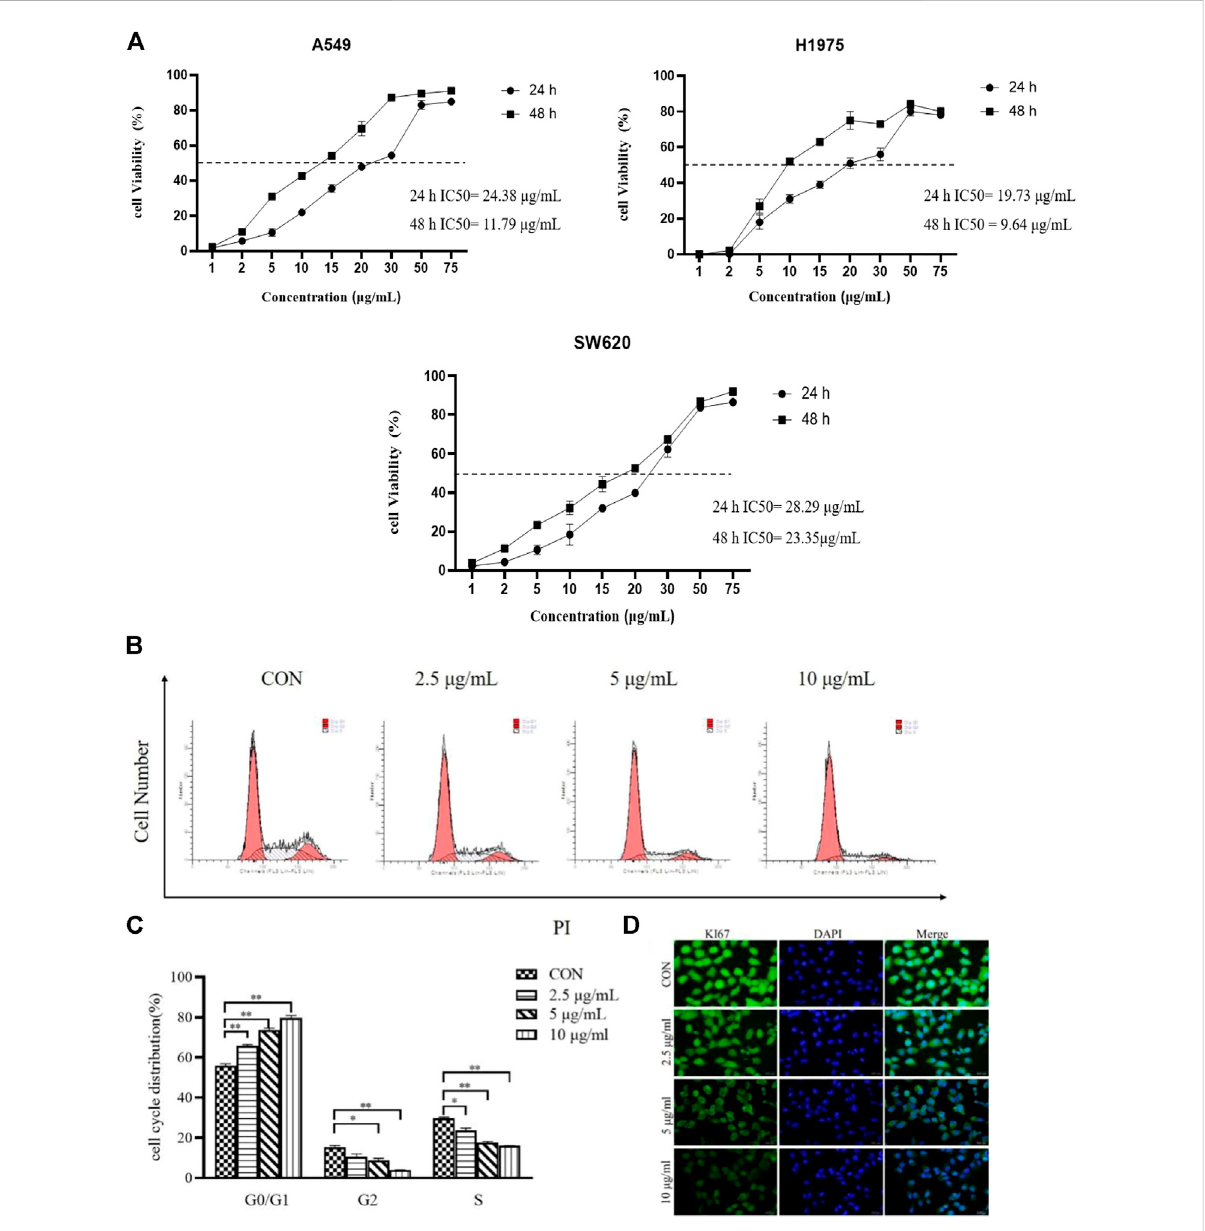
EffectsofTTHonproliferationofH1975. (A) H1975(A549,SW620)cellsweretreatedwithvariousconcentrations(1,2,5,10,15,20,30,50,75 µg/ ml)ofTTHfor24and48 h,respectively. (B) H1975cellsweretreatedwithTTHat2.5 µg/ml,5 µg/mland10 µg/mlfor48